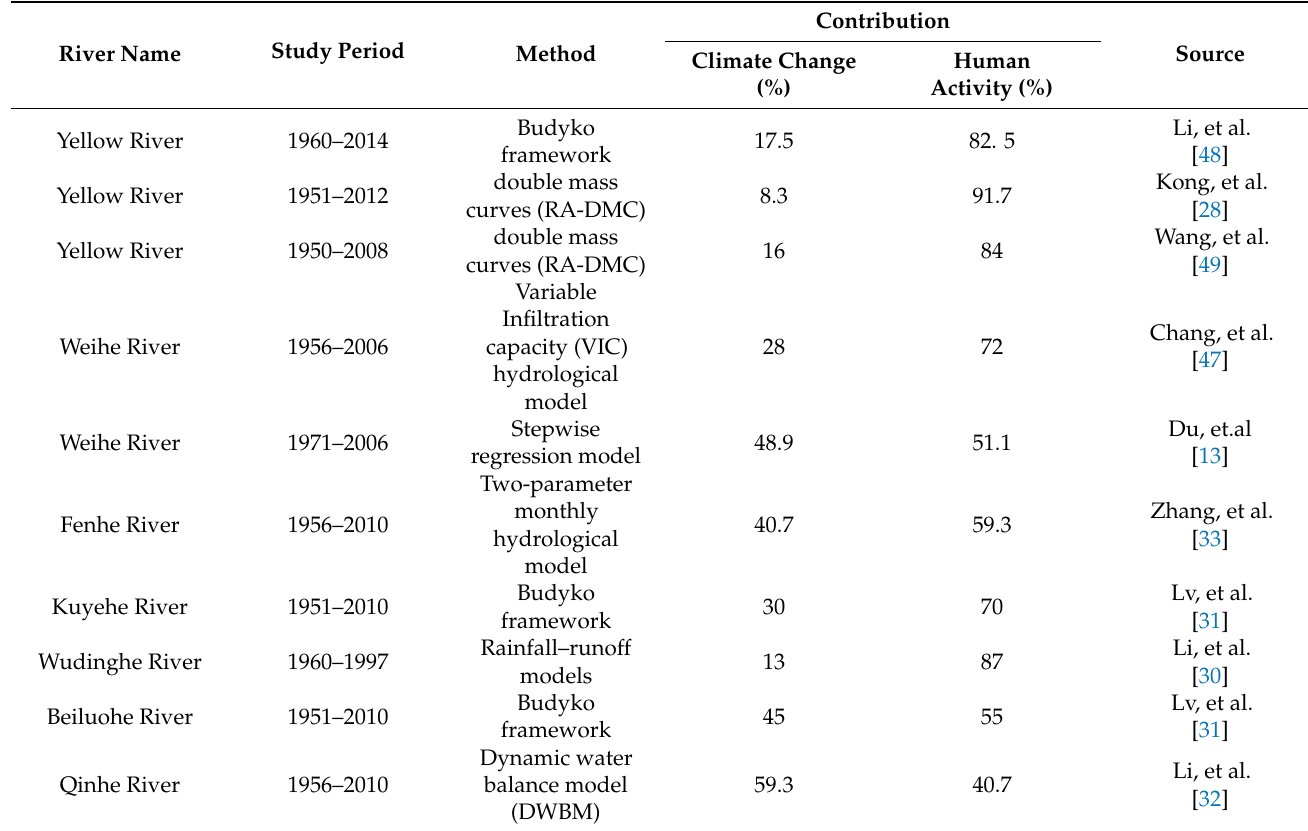
Table 7. Previous attribution analysis on the runoff change in the Yellow River